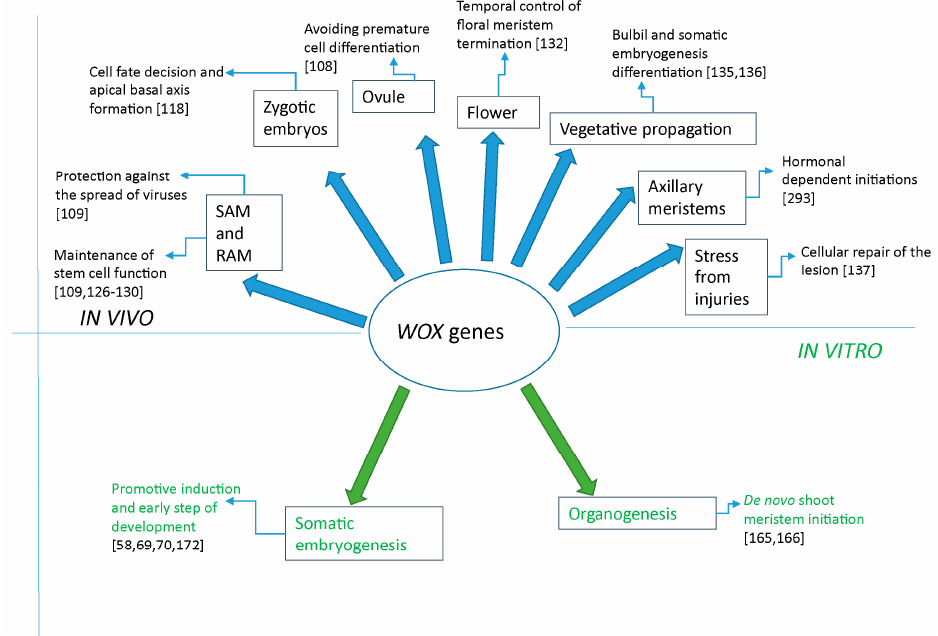
Figure 4. Schematic representation of some major roles of WOX genes in vivo and in vitro in plants. The diagram is simplified, and bibliographic references are partial.